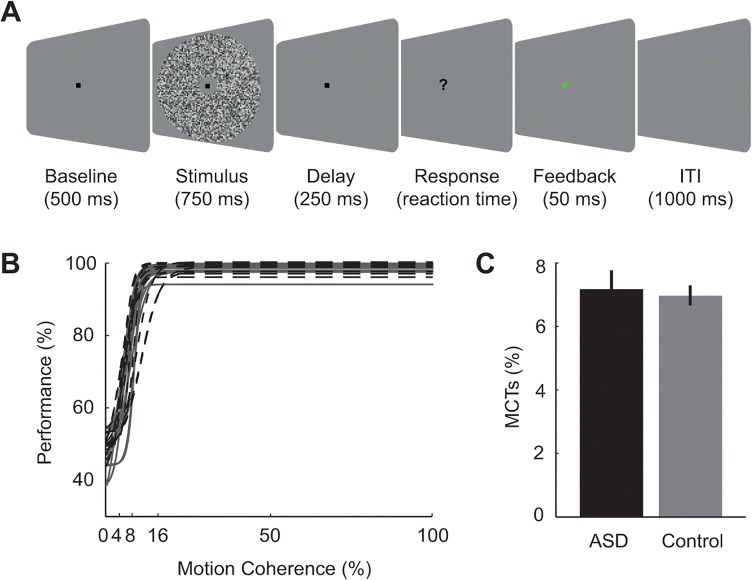
Experimental design and psychophysics.(A) Motion discrimination task. Trials started with the onset of a central fixation dot. After 500 ms, the motion stimulus was presented for 750 ms in a circular aperture. Motion coherence across stimuli ranged from 0% to 100% with either upward or downward motion direction. Following a fixed delay period, the fixation dot was extinguished and a question mark prompted the participants to report the perceived motion direction (left button = “upwards”, right button = “downwards). Participants were given a brief visual feedback (green = “correct”; red = “incorrect”). The trial ended with a blank inter-trial interval (ITI). (B) Curves represent the group-average logistic function fitted to the average motion detection performance of the control (gray solid lines) and ASD (black dashed lines) group. (C) Bar graphs illustrate the mean motion coherence thresholds (MCTs; i.e., coherence level at which 75% of motion discriminations were correct) for each group, assessed on the basis of logistic functions fitted to the individual data. Error bars represent the standard error of the mean.